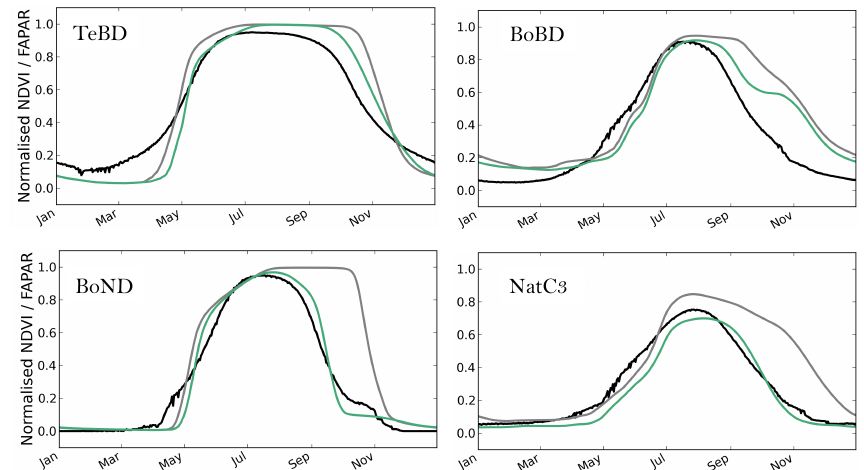
Figure 4. Mean seasonal cycle (2000–2008) of the normalized modeled FAPAR before and after optimization, compared to that of the MODIS NDVI data, for the temperate and boreal deciduous PFTs (TeBD, BoBD, BoND and NatC3). Black = MODIS NDVI data; gray = prior simulation (default ORCHIDEE parameters); green = posterior multi-site optimization.